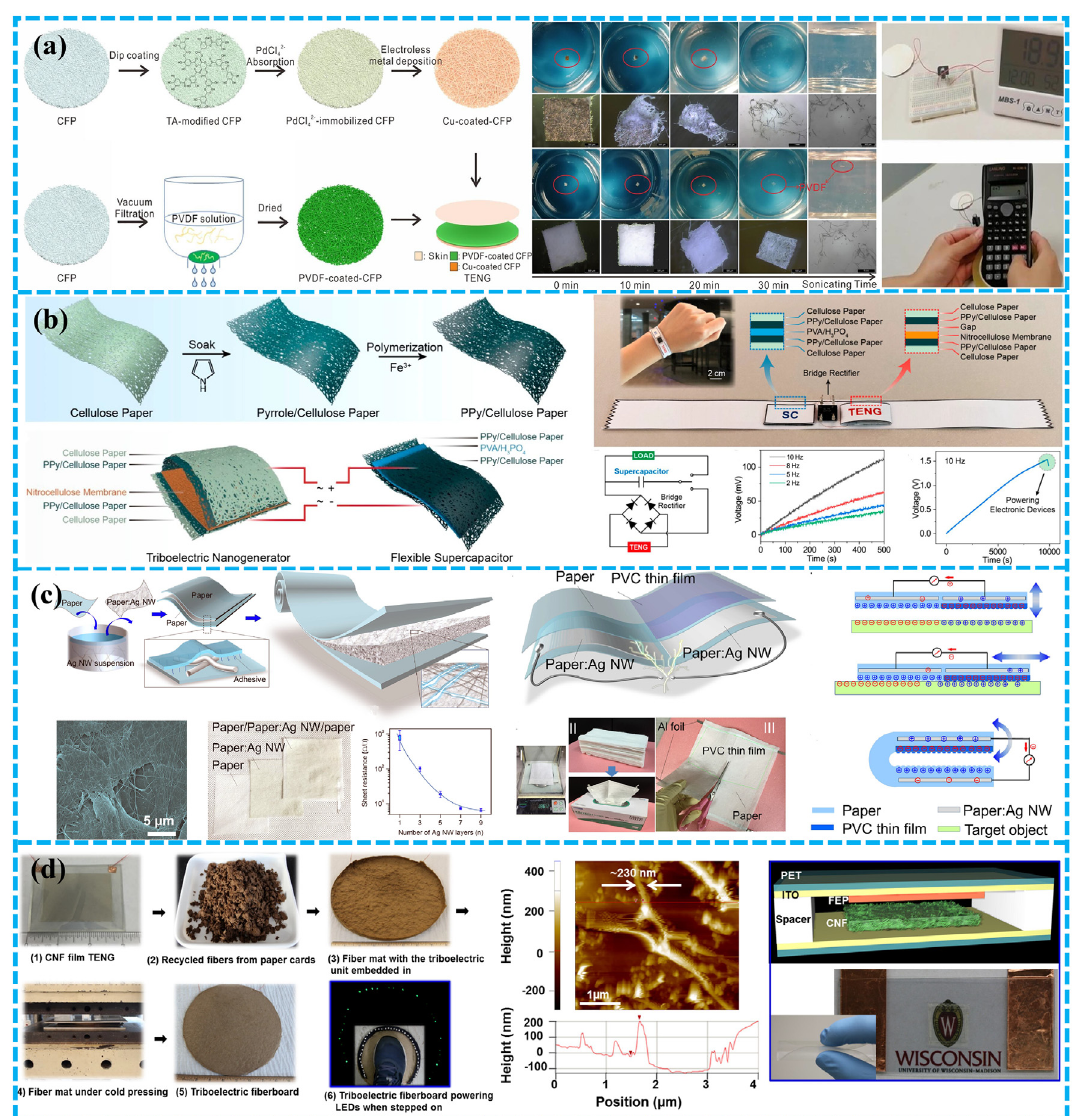
Figure 5. Plant-based BD-TENGs. ( a ) A green, recyclable, and biodegradable CFP-based TENG; A schematic illustration of the fabrication of Cu-coated CFP and PVDF-coated CFP; degradation process of various membranes and the application of TENG based on CFP. Reproduced with permission [82]. Copyright 2022, Elsevier B.V. ( b ) A portable self-charging power supply system integrated with TENG and SC based on cellulose paper and PPy-coated cellulose paper; a schematic diagram of the manufacturing process of PPy coated cellulose paper and the structure diagram of the self-charging power system. Reproduced with permission [83]. Copyright 2020, WILEY-VCH. ( c ) An ultra-soft and cuttable paper-based TENG for mechanical energy harvesting; a schematic illustration of the process used to fabricate the conductive paper; a P-TENG schematic diagram and various working modes; demonstrations of its portability and ability to be tailored. Reproduced with permission [40]. Copy- right 2019, American Chemical Society. ( d ) A renewable and BD-CNF-based TENG; manufacturing and performance of CNF-based TENG fiberboard. Reproduced with permission [84], Copyright 2016, Elsevier Ltd. BD-TENG based on rice paper and bacterial